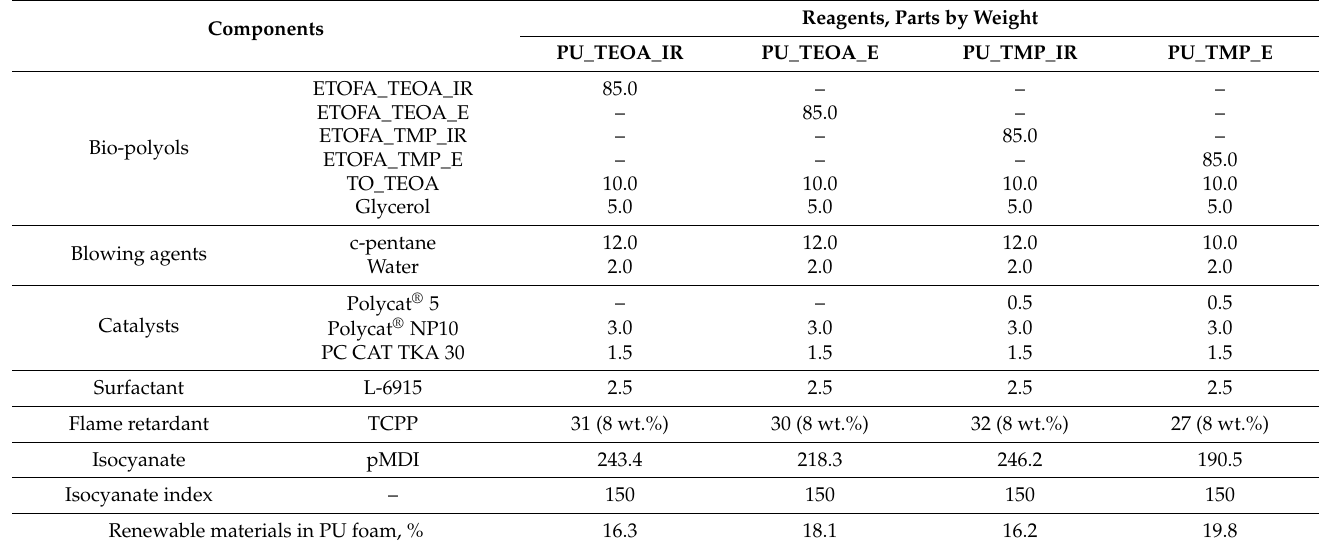
Table 2. Polyurethane (PU) foam formulations and renewable material content in PU foams.